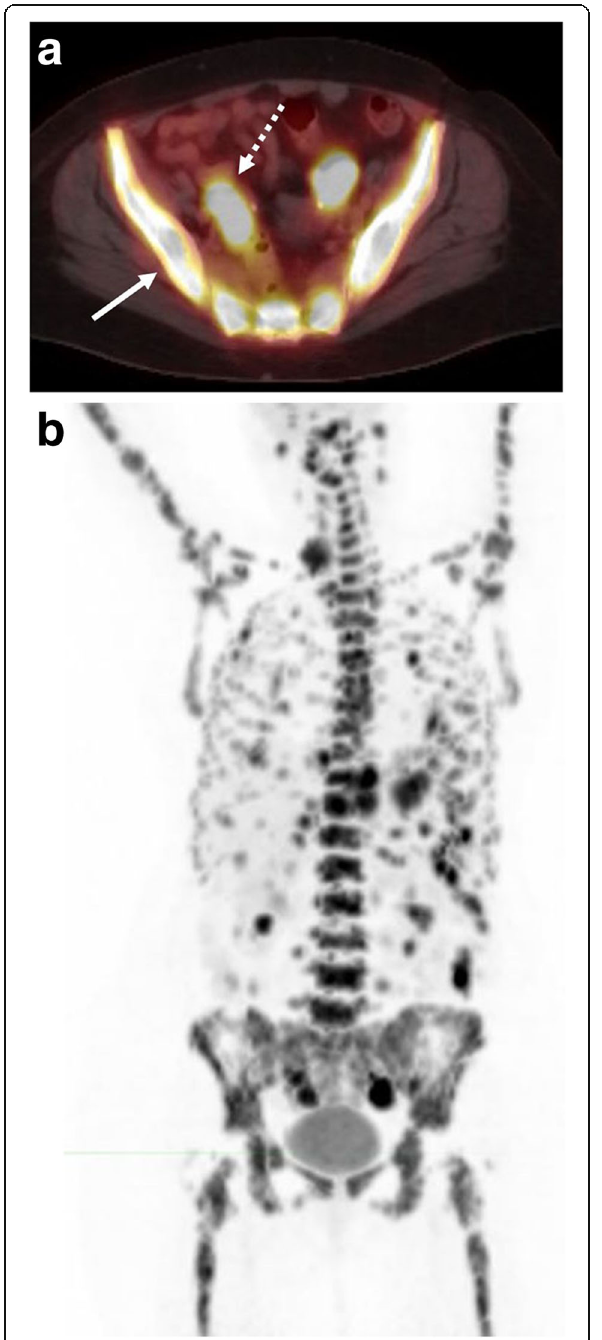
Fig. 13 Diffuse marrow involvement. A 74-year-old female with known Burkitt lymphoma. a Fused axial PET-CT demonstrates diffuse hypermetabolic activity within the visualized marrow of the pelvis (solid arrow). Soft tissue activity is also seen within the pelvis (dashed arrow). b Whole body planar PET image demonstrates both diffuse marrow and soft tissue disease within the lower neck, thorax, abdomen, and pelvis